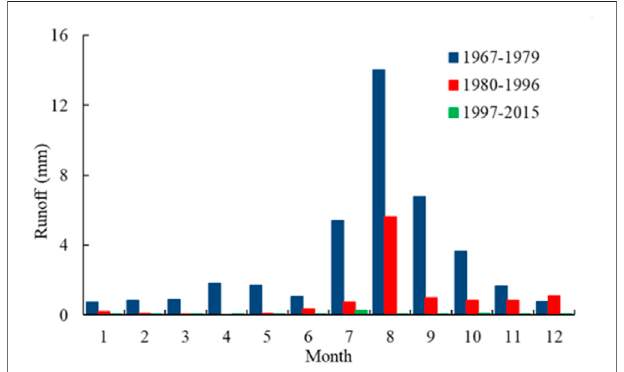
FIGURE 7 | The percentage of precipitation anomalies during 1967 – 2015 in the Zhulong River